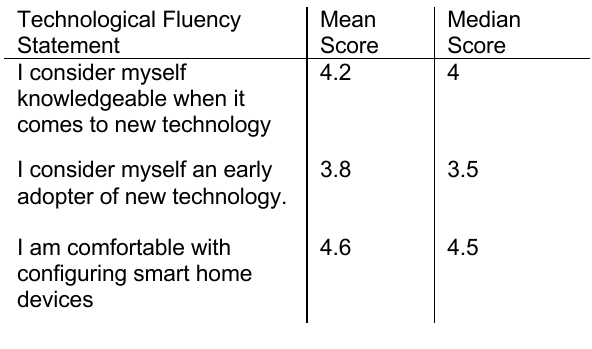
Table 1. Self-reported technological fluency of participant